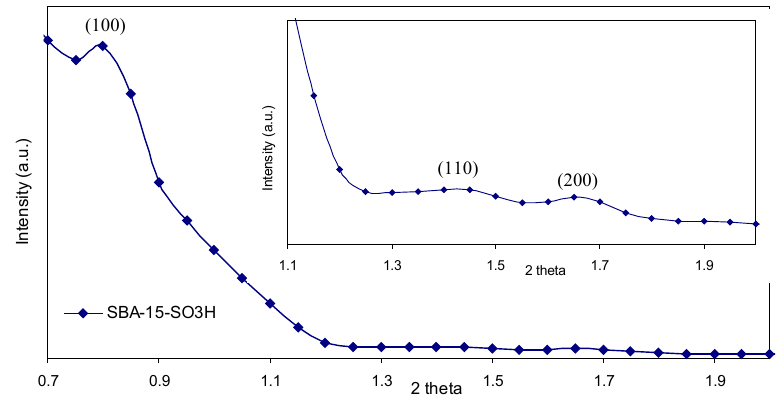
H between 0.7 and 2.0 o (between 1.1 and 2.0 o is in inset). 3